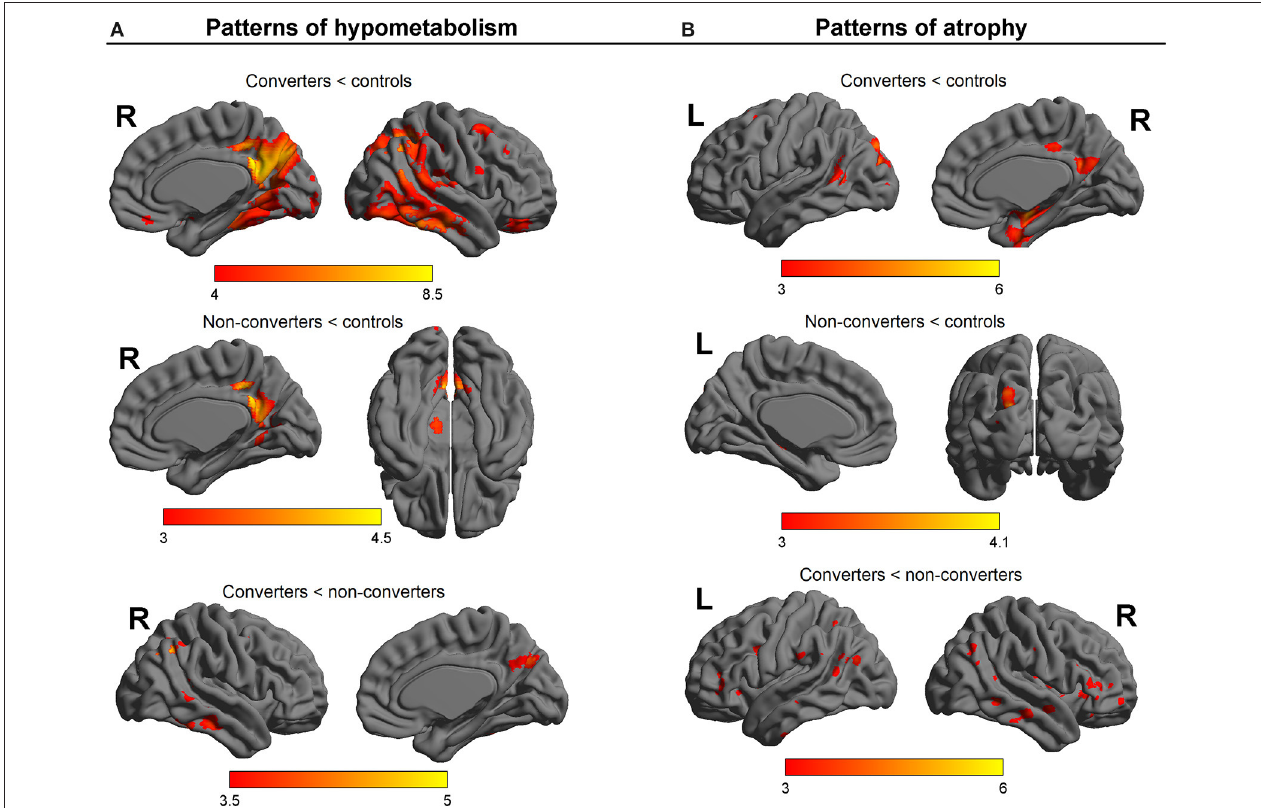
FIGURE 2 | SPM results of group comparisons on (A) PET images of cerebral metabolism and (B) MR images of gray matter density. Color scale: T